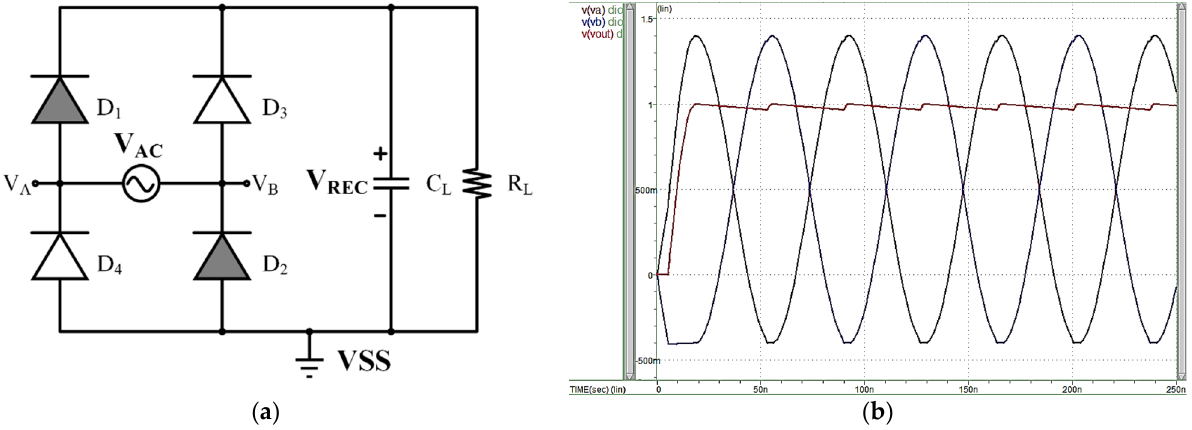
Figure 3. ( a ) Full-wave diode bridge rectifier architecture. ( b ) Simulated full-wave diode bridge rectifier (Vth ≈ 0.4 V).